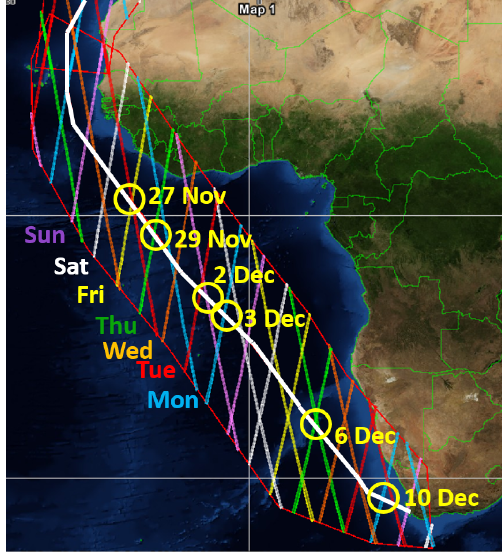
Figure 1. Ground tracks of Aeolus (thick colored lines). Each color represents another weekday as indicated in the plot. The thick white line represents the ship track of RV Polarstern . The yellow circles indicate the points of intersection of RV Polarstern and the Aeolus ground track for which additional radiosondes were